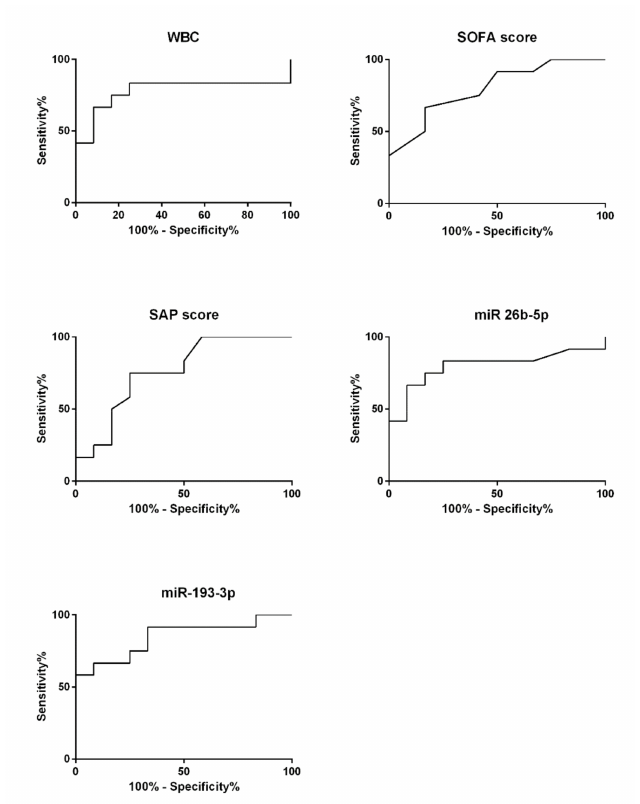
Figure 6. Receiver operating characteristic (ROC) curve analysis was performed on all parameters that showed significant group di ff erences between the septic intensive care (SIC; n = 12, n = 2) and the non-septic intensive care (NIC; n = 12, n = 2)